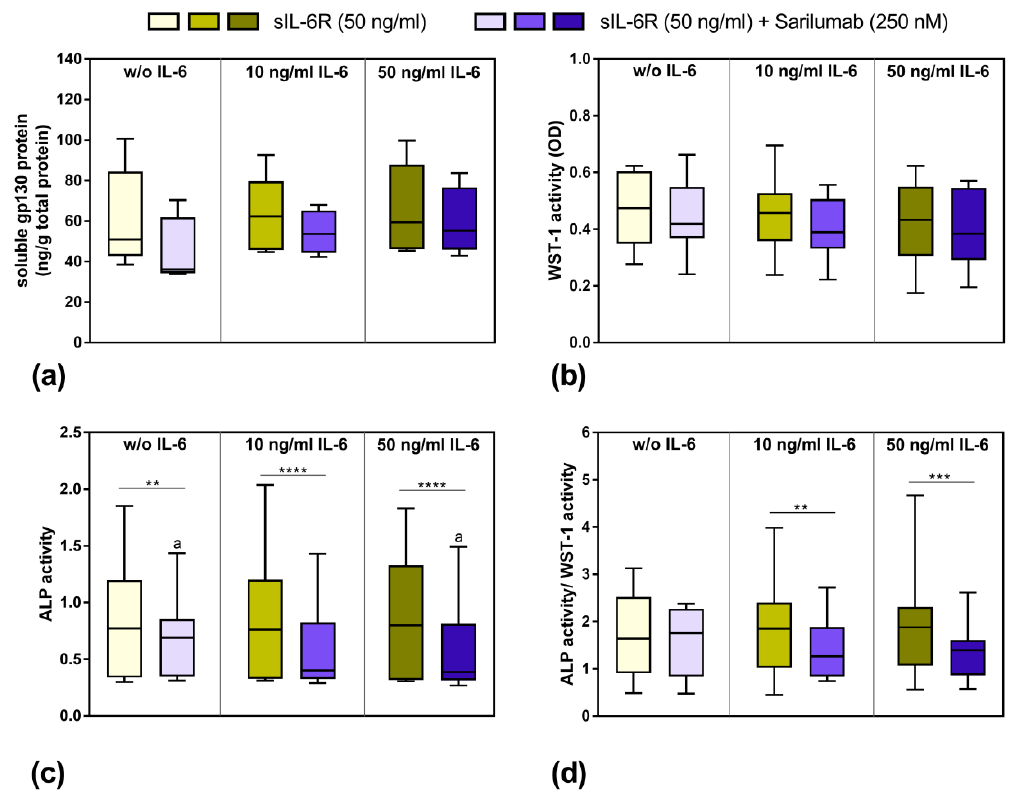
Figure 4. Release of soluble gp130 (sgp130), osteoblastic viability, and alkaline phosphatase (ALP) activity after exposure to IL-6, sIL-6R ± sarilumab for 72 h. ( a ) Secreted sgp130 was determined in supernatants of exposed osteoblasts in passage 3 ( n = 4 independent donor (female: n = 3, male: n = 1; mean age: 77.5 ± 5.1 year) — n = 5 independent donors (female: n = 4, male: n = 1); mean age: 77.8 ± 4.4 year). ( b ) Cell viability was tested via water-soluble tetrazolium salt (WST-)1 assay ( n = 12 independent donors in passage 3 (female: n = 8, male: n = 4); mean age: 67.3 ± 16.1 year). ( c ) Alkaline phosphatase (ALP) activity of osteoblasts, which was quantified via hydrolysis of p-nitrophenyl phosphate ( n = 12 independent donors in passage 3 (female: n = 8, male: n = 4); mean age: 67.3 ± 16.1 year). ( d ) ALP activity related to metabolic activity ( n = 12 independent donors in passage 3 (female: n = 8, male: n = 4); mean age: 67.3 ± 16.1 year). All data are shown as box plots. Statistical significance was determined via repeated-measures two- way ANOVA with Bonferroni’s post hoc test: ** p < 0.05; *** p < 0.001, **** p < 0.0001 (significantly different from samples with sarilumab costimulation); a p < 0.05 (significance between IL-6 concentrations).